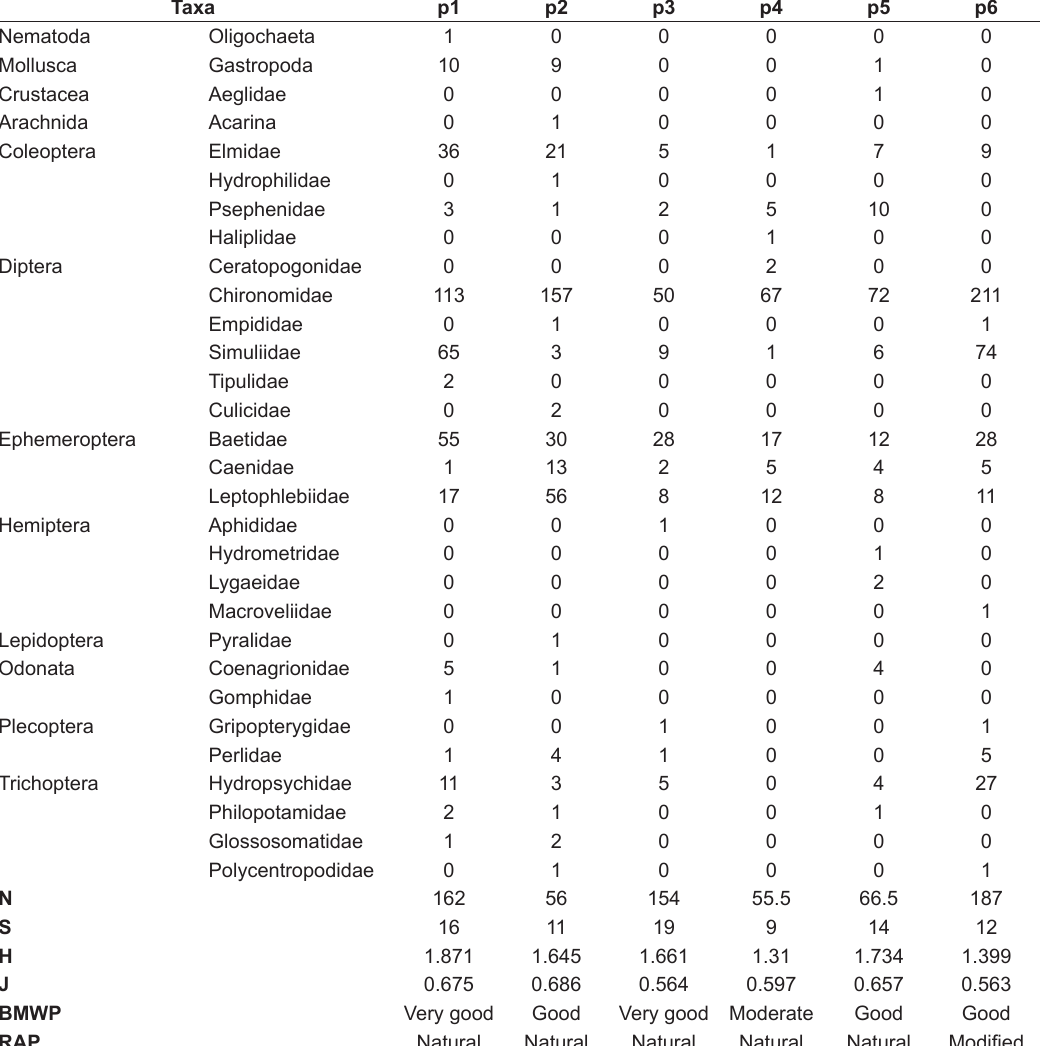
Table 2. Total density (N, ind.m –2 ), richness of taxa (S, number of taxa ), Shannon diversity (H), and Pielou evenness (J) of the benthic macroinvertebrate assemblages. Biotic index (Biological Monitoring Working Party – BMWP) and Rapid Assessment Protocol (RAP) applied in sampling sites located within and outside the Mata do Rio Uruguai Teixeira Soares Municipal Natural Park, Marcelino Ramos,